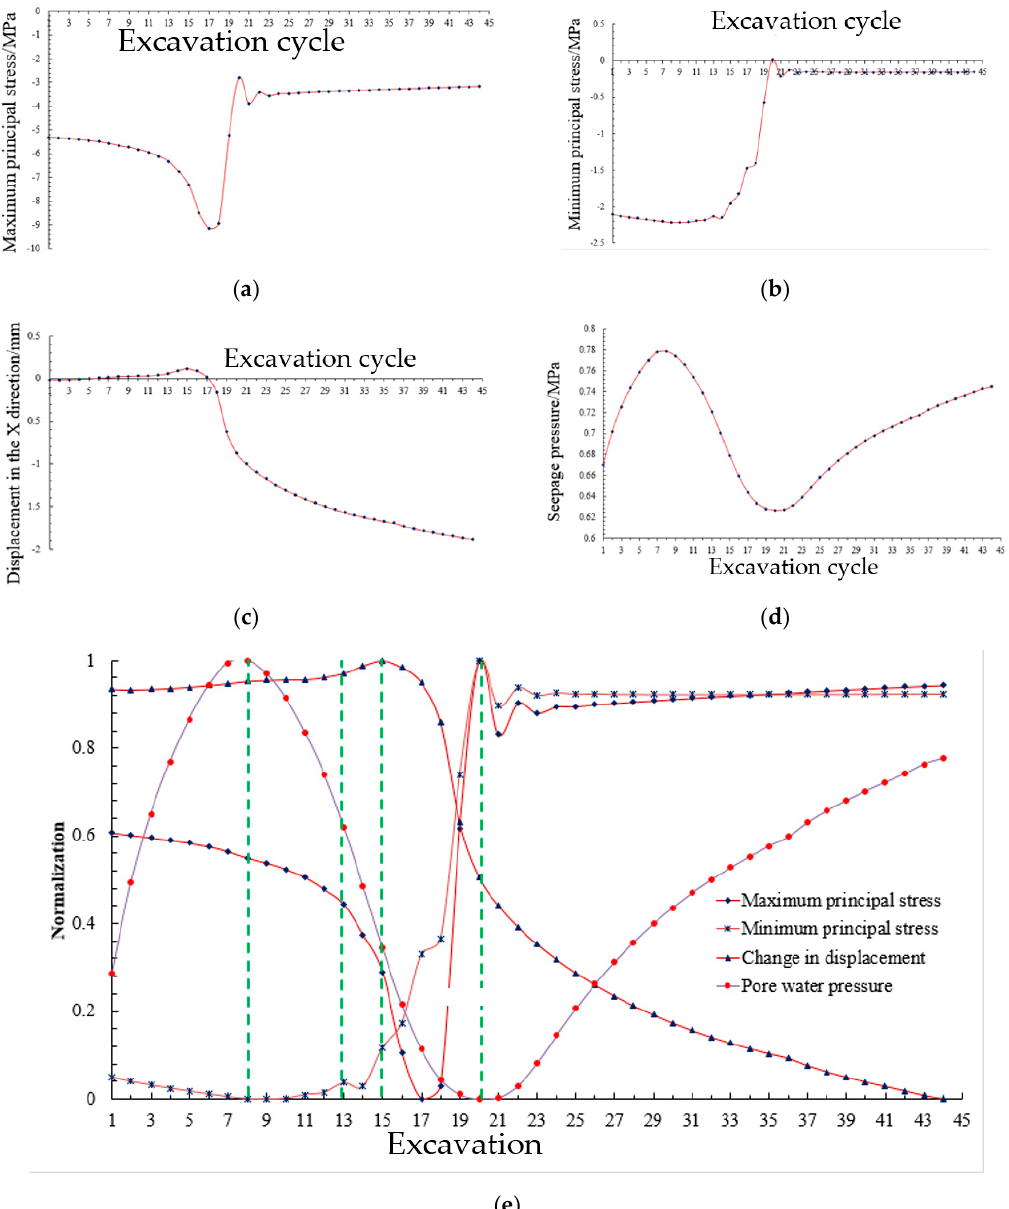
Figure 13. Variation curves of multivariate information at the monitoring point Z-1. ( a ) Time history of maximum principal stress; ( b ) Time history of minimum principal stress; ( c ) Time history of displacement in the x direction; ( d ) Time history of seepage pressure; ( e ) Normalization curves of linear functions.